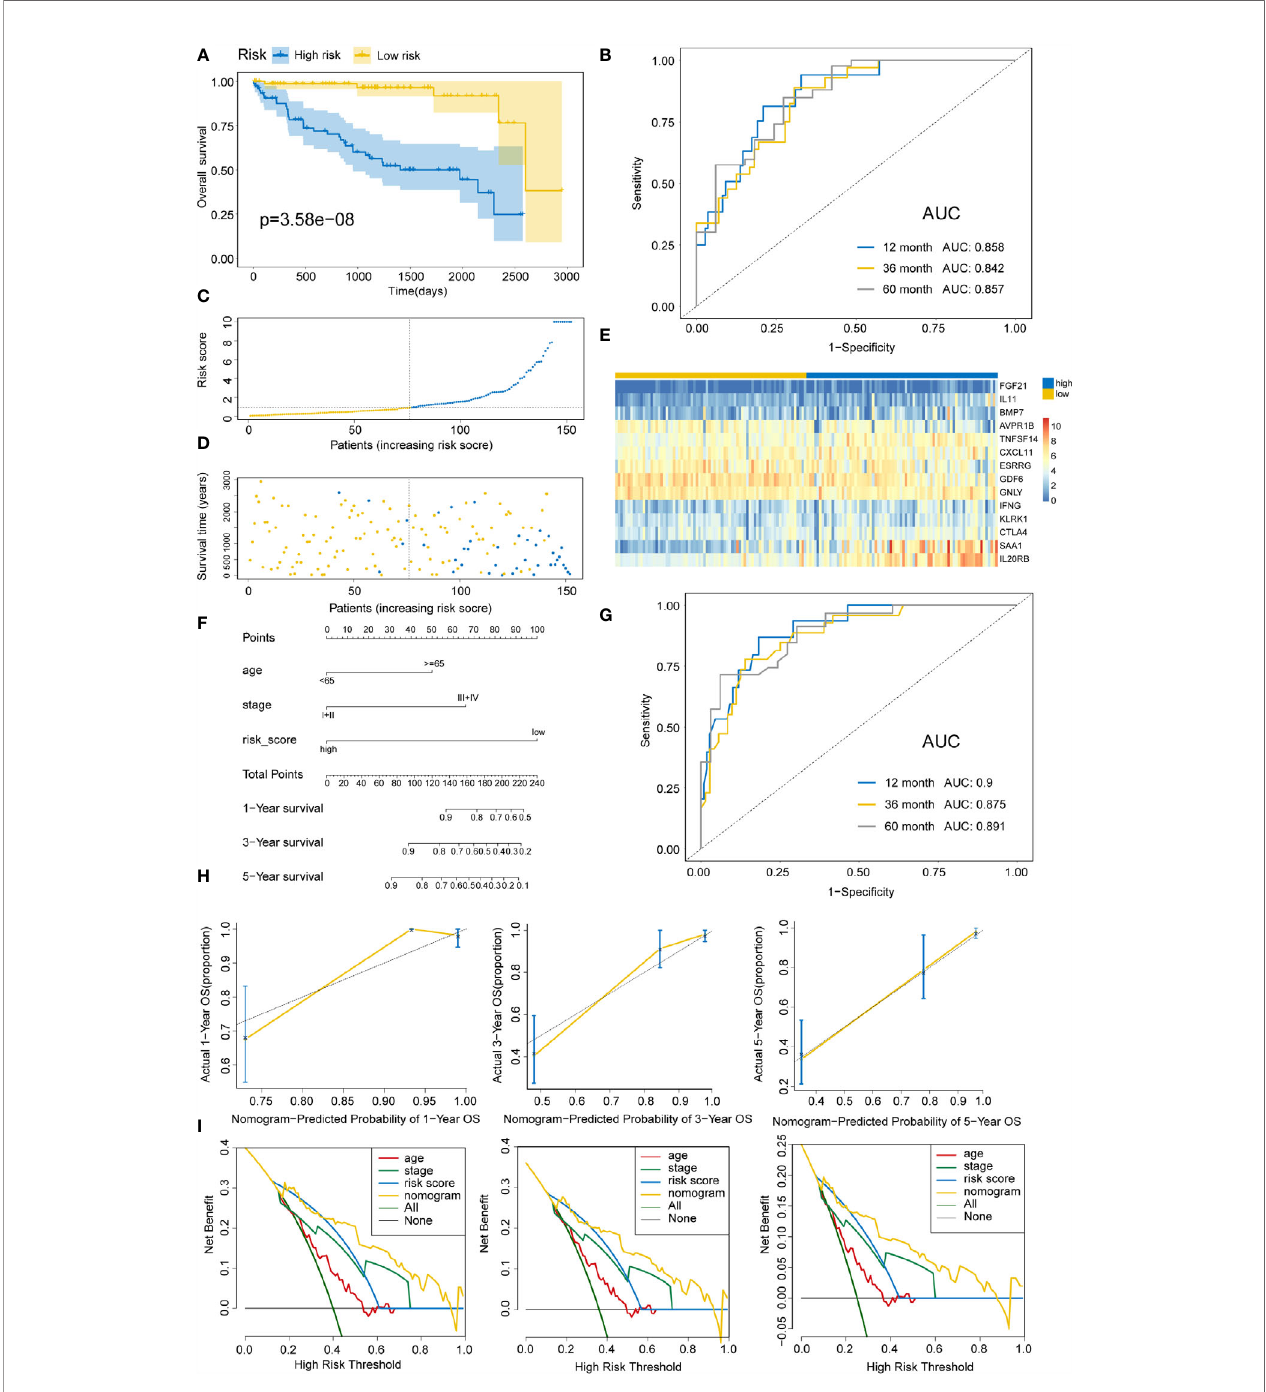
FIGURE 5 | Validating immune risk score prognostic predictive model in the testing set. (A) Kaplan – Meier curves for OS outcomes in the testing cohort divided by high- and low-risk score groups. (B) The time-dependent ROC curves for predicting 1-, 3-, and 5-year survival outcomes using this signature. (C) Risk score distribution in the testing cohort. (D) Vital statuses of patients in high- and low-risk patients. (E) Expression patterns for 14 immune-associated genes in the high- and low-risk score cohorts. (F) Nomogram developed for the prediction of probabilities for 1-, 3-, and 5-year OS outcomes in the testing cohort. Risk scores and other independent prognostic factors were incorporated in the nomogram. (G) Time-dependent ROC curves for prediction of 1-, 3-, and 5-year survival outcomes using the nomogram. (H) Calibration plot of nomogram in the training cohort according to the agreement between estimated and observed 1-, 3-, and 5-year outcomes. Dashed lines represent the nomograms ’ ideal performance. (I) Decision curve analysis for 1-, 3-, and 5-year risk using the nomogram. Black line represents the hypothesis that no patient died after 1-, 3-, and